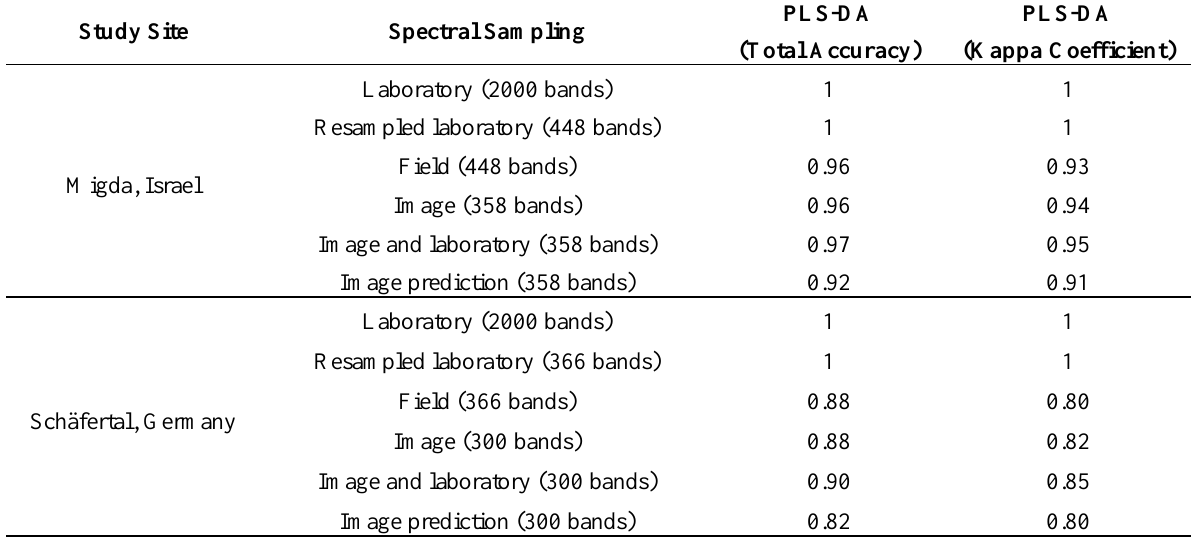
Figure 10. Partial least squares-discriminant analysis (PLS-DA) classification of the different land uses in the Schäfertal site, Germany, using data of: ( A ) field spectroscopy; ( B ) laboratory spectroscopy; ( C ) airborne imaging spectroscopy; and ( D ) merged image and laboratory spectroscopy. Dashed circles indicate the 95% confidence level. Table 8. The results of the classification total accuracy and the kappa coefficient of PLS-DA models as derived for the different land uses of the soil spectral sampling, for the Migda, Israel and Schäfertal, Germany